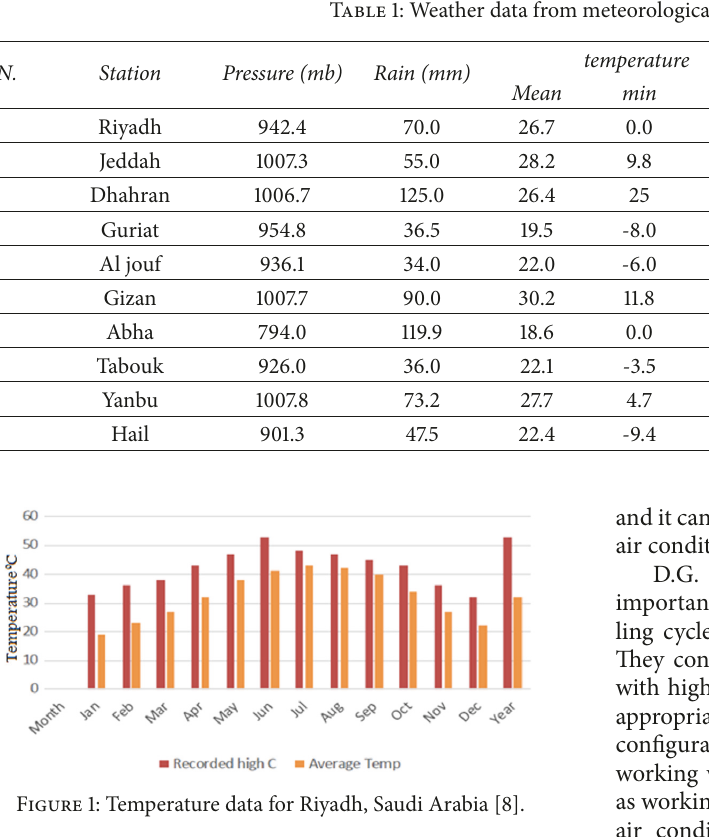
during one year. The average of high recorded temperature is 42.6 Celsius and the average of the temperature averages is 32.2